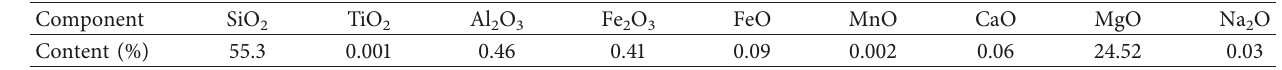
Table 1: Sepiolite component.